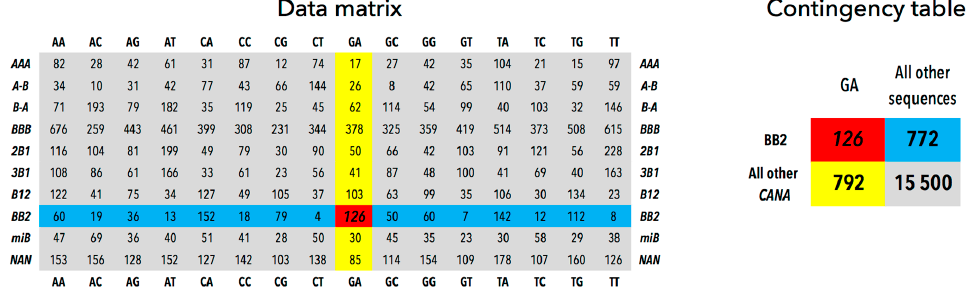
Figure 2. Construction of a contingency table. The BB2/GA association in complexes with regulatory proteins has 126 incidences (red matrix element), the other BB2 letters account for 772 (blue highlight), and the sequences other than GA for 792 (yellow highlight) incidences. There are 15,500 incidences of the remaining CANA/sequence combinations (grey).